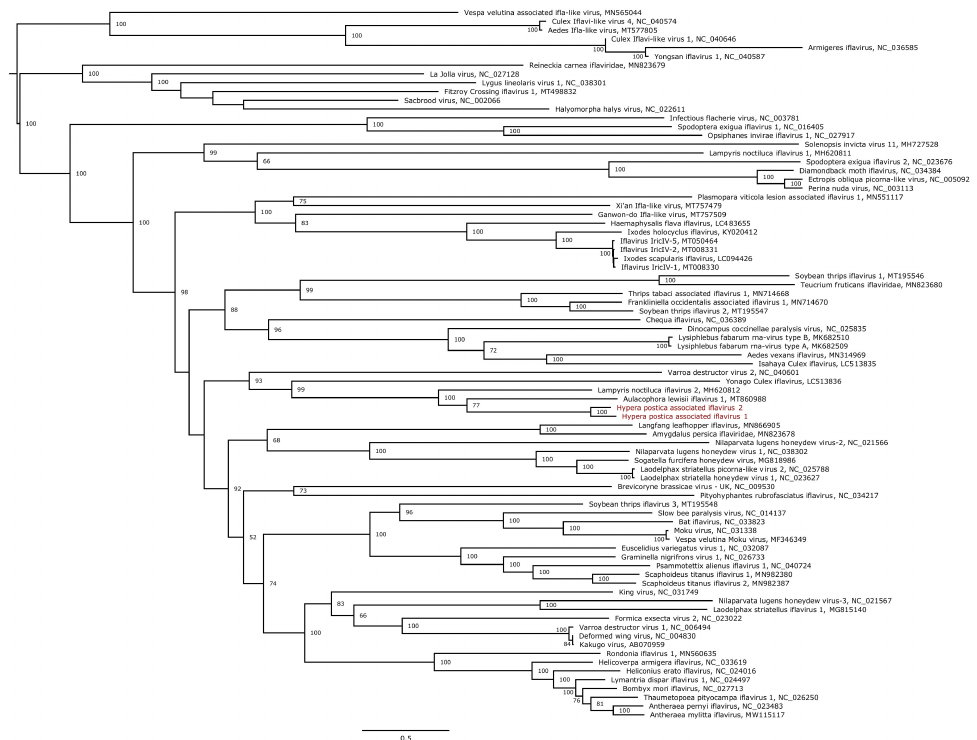
Figure 7. Maximum likelihood phylogenetic tree based on the polyprotein of 81 iflaviruses. Viruses reported in this study are marked in red. The tree was mid-point rooted. Bootstrap values (100 replicates) superior to 50% are indicated at each node. Scale bar corresponds to amino acid substitutions per site.